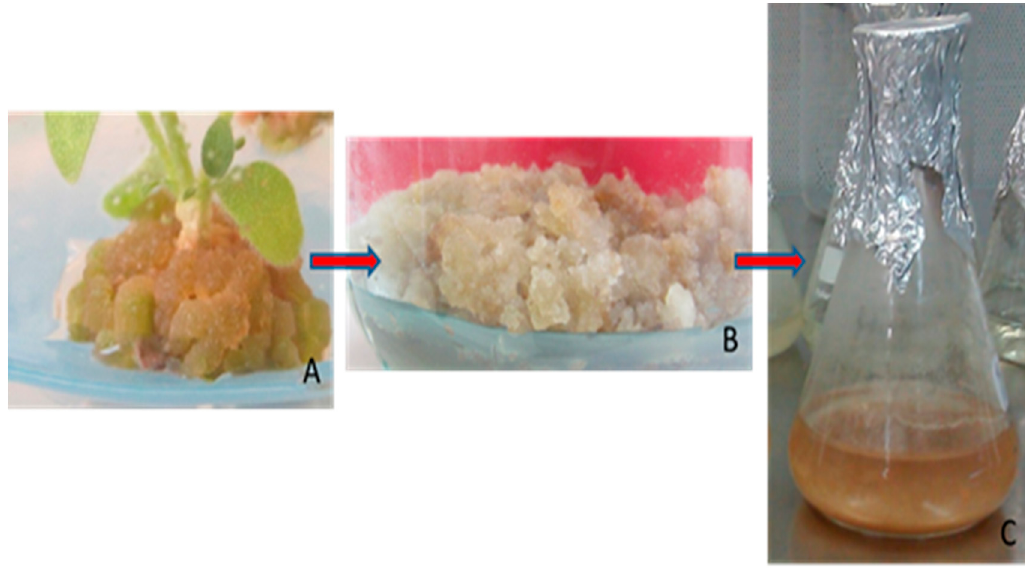
Figure 5. Steps for obtaining cell suspensions of S. khuzistanica . ( A ) Plantlet in vitro culture developing callus; ( B ) Callus culture; ( C ) Cell suspension.